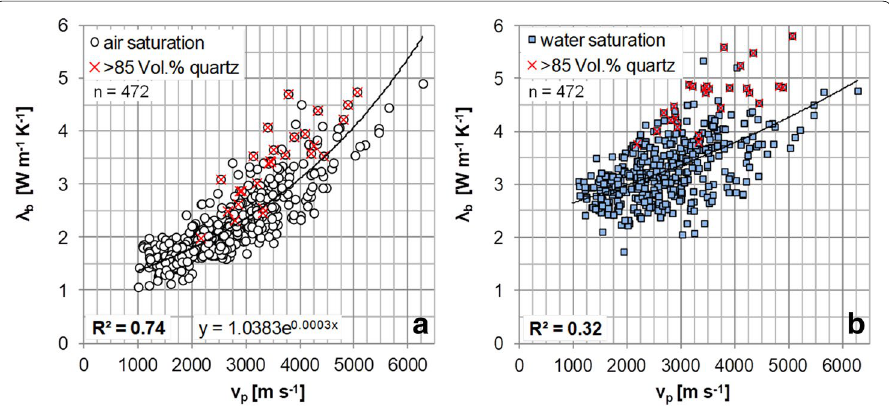
Fig. 9 Cross-plots of P-wave velocities v p (air-saturated samples) and bulk thermal conductivities ( λ b ) of a air-saturated sandstone samples and b water-saturated sandstone samples, revealing a coefficient of determination R 2 of 0.74 and 0.32. λ b and v p are measured parallel to the orientation of the sedimentary stratification bedding. Samples containing > 85 vol.% total quartz are highlighted by a red x, as they plot as